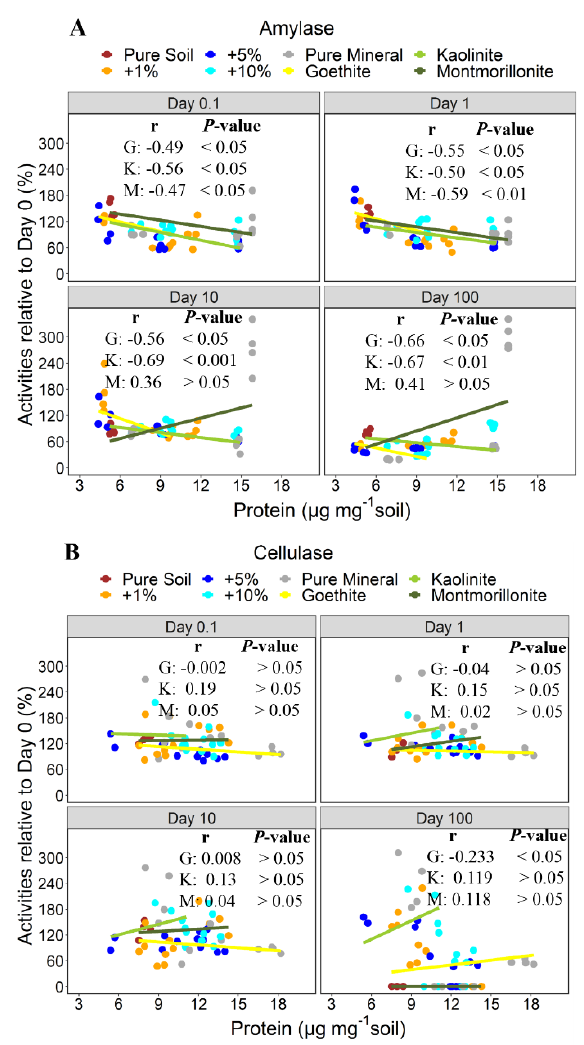
Figure 5. Persistence of activities of amylase ( A ) and cellulase ( B ) normalized to the amount adsorbed protein. Points represent the persistence of activities in the pure soil, the mineral additions variants, and the pure minerals ( n = 4). Lines indicate trends in relationships with the protein contents based on types of minerals. G = goethite, K = kaolinite, and M =